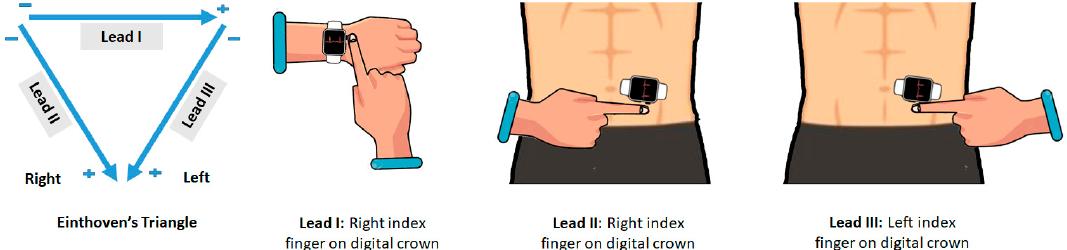
Figure 1. The positioning of the Apple Watch Series 4 for obtaining leads 1, II, and III using the Einthoven triangle. In the Apple Watch, the negative electrode is placed in the digital crown and the positive electrode is on the back crystal of the watch .